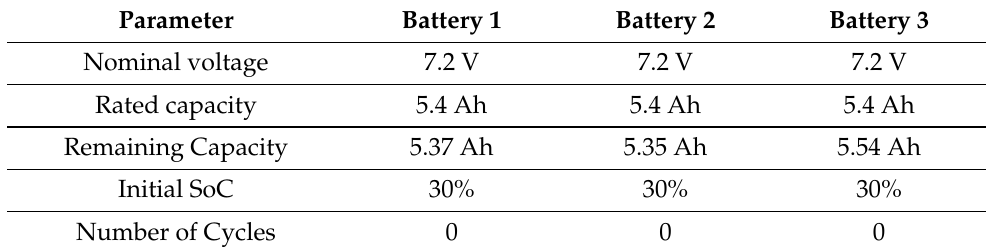
Table 4. Batteries parameters.